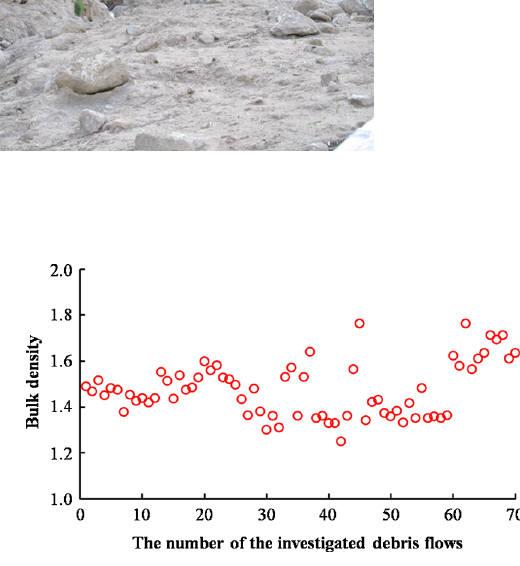
Figure 3. Density characteristics of debris flow deposits in the study